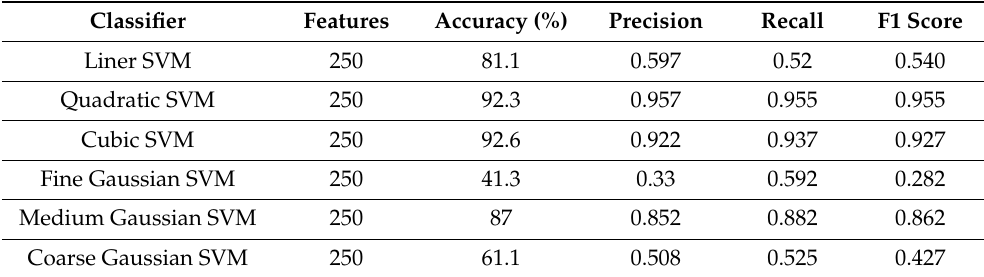
Table 1. Experiment Setup